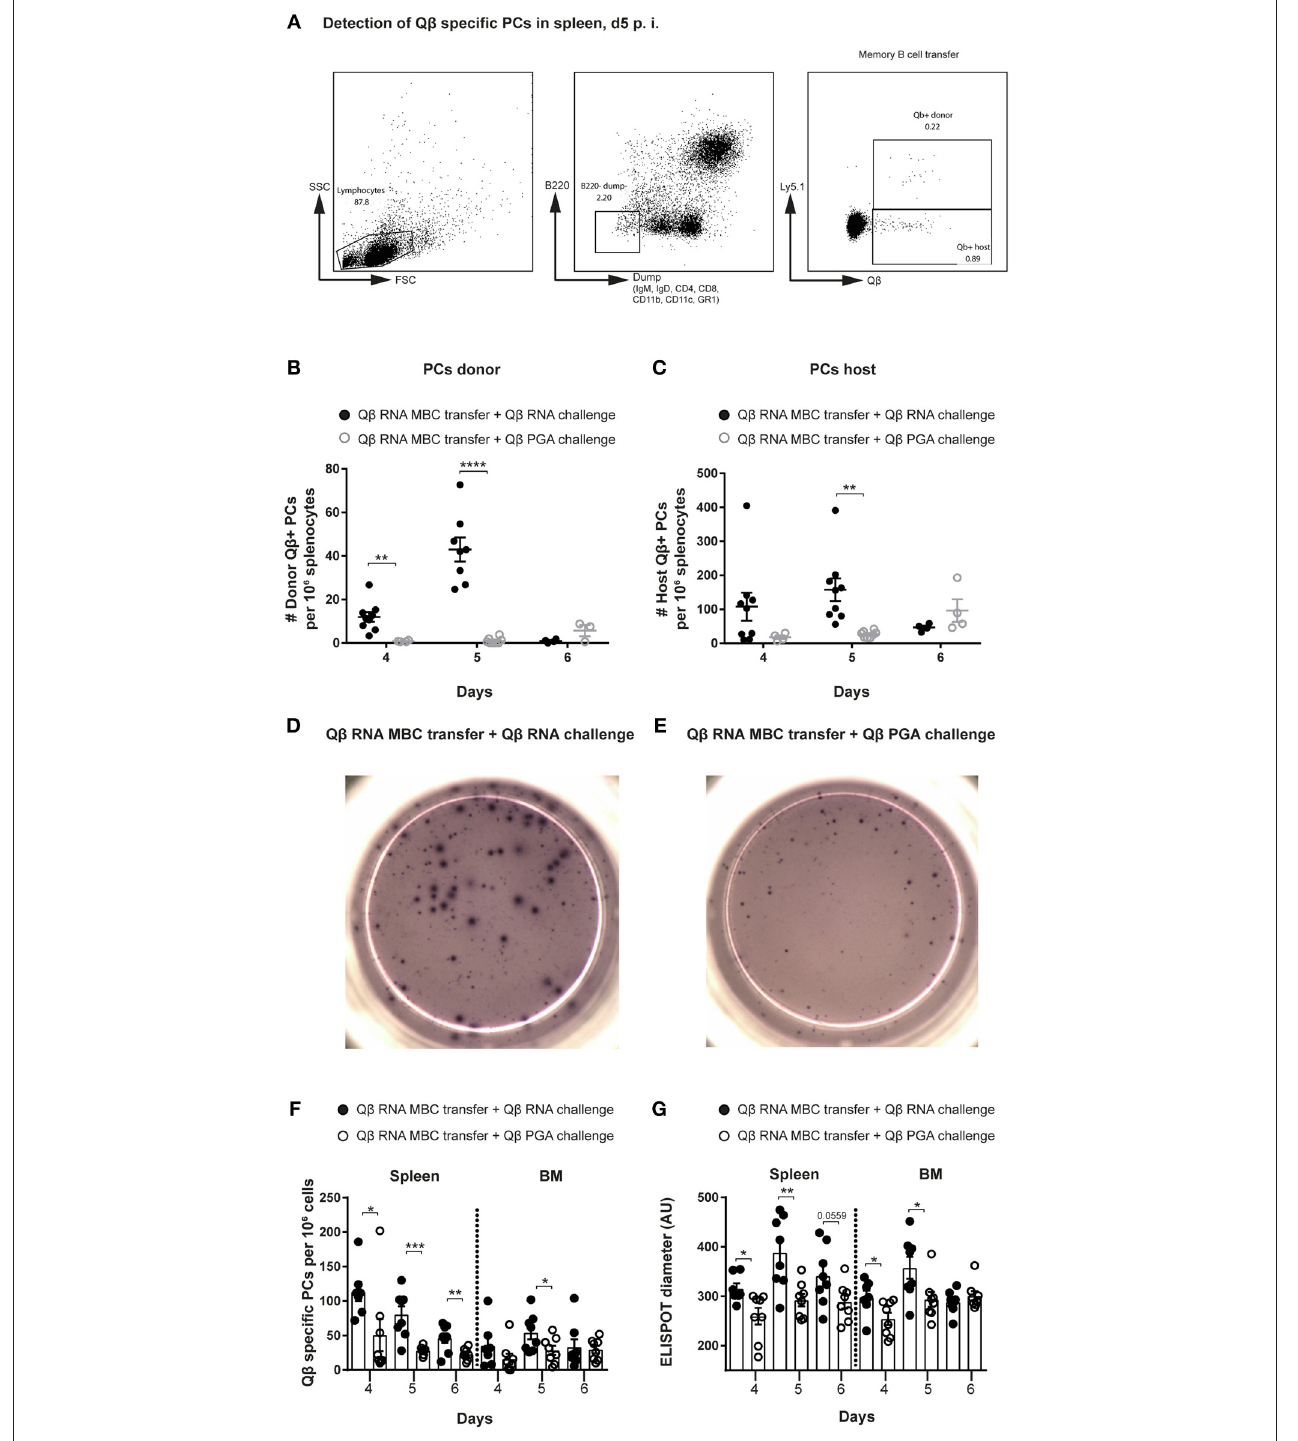
FIGURE 2 | Presence of bacterial RNA during challenge of memory B cells is essential to generate secondary PCs. Memory B cells were generated by immunizing Ly5.1 mice (donor) with 50 µ g Q β -RNA. One day after transfer of MACS purified memory B cells, allotypic Ly5.2 hosts were challenged with 50 µ g Q β -RNA or 50 µ g Q β -PGA, respectively. (A) Representative FCM plots for the gating strategy to identify Q β -specific PCs in the spleen 5 days after transfer and challenge. B220 low cells not expressing IgM, IgD, CD4, CD8, CD11b, CD11c, or GR1 were analyzed for their intracellular binding of labeled Q β VLPs. The congenic Ly5 marker was used to discriminate transfer from host derived PCs. (B,C) FCM analysis of the specific PC compartment at day 4, 5, and 6 after transfer of memory B cells induced with Q β -RNA and challenged with Q β -RNA (black circles) or Q β -PGA (gray circles). Number of Q β -specific donor (B) or host (C) derived PCs within the B220 low , IgM, IgD,